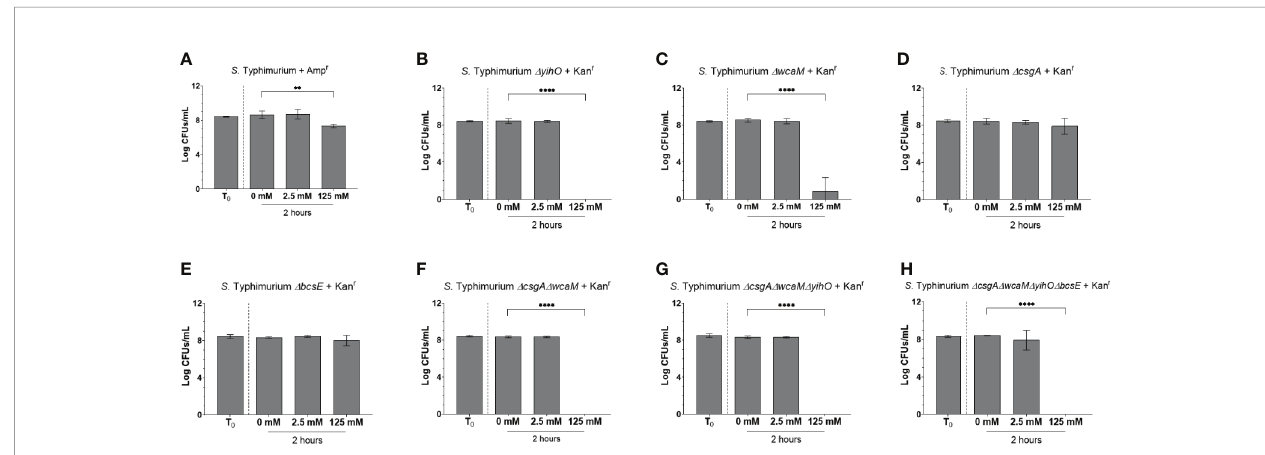
FIGURE 1 | Tolerance of WT S. Typhimurium and EPS mutants to H 2 O 2 . (A – H) Bio fi lm aggregates carrying an antibiotic resistance cassette were challenge with H 2 O 2 at a known tolerable dose (2.5 mM) and a challenge dose (125 mM). Statistical signi fi cance was determined by one-way ANOVA with Dunnett correction for multiple comparisons (**p < 0.01; ****p < 0.0001). Each experiment was conducted in triplicate and the data represents the mean of three independent experiments. The error bars indicate